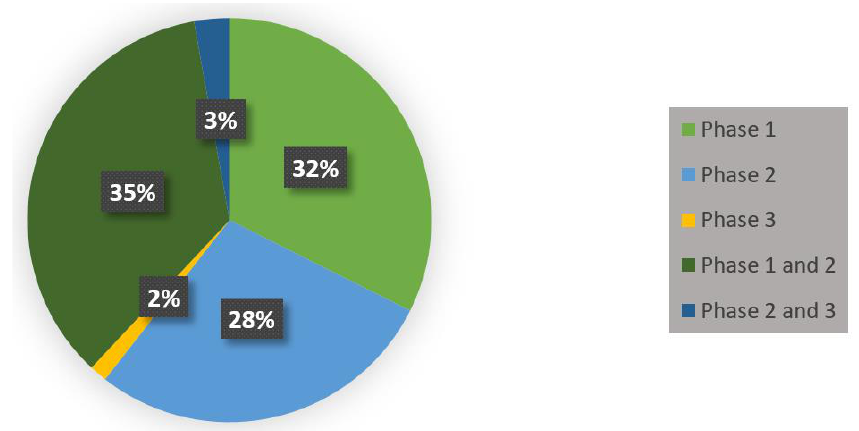
Figure 6. COVID-19, ARDS and sepsis MSC-based therapy-related clinical trials in phase 1, phase 1 and 2, phase 2, phase 2 and 3, and phase 3.